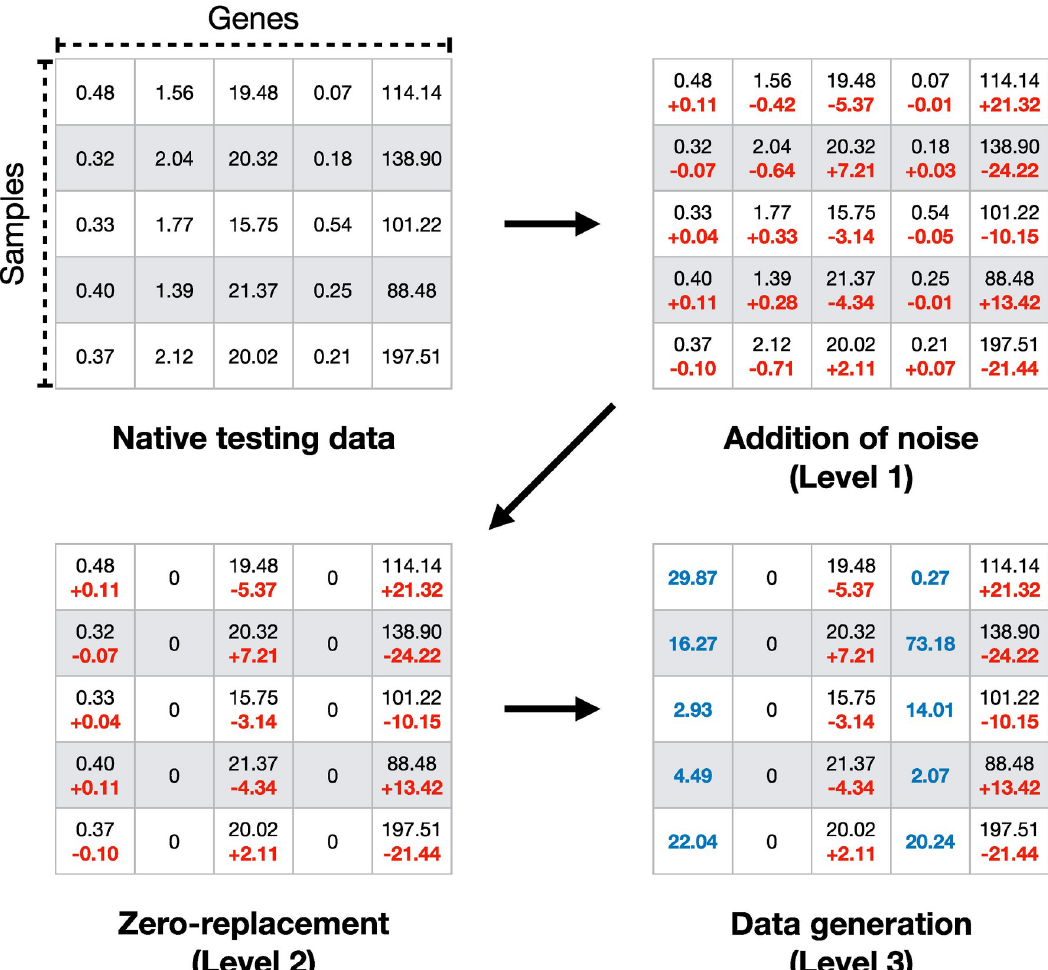
Fig 1. Mechanisms of data degradation. Data manipulation is shown for a random sample dataset. Native testing data are randomly degraded in three cumulative levels. First, noise is added to all expression values to generate minor fluctuations. At the second level, gene expression information is removed by zero-replacement. In the last step, simulated but plausible data replaces both real expression values and zero-replaced